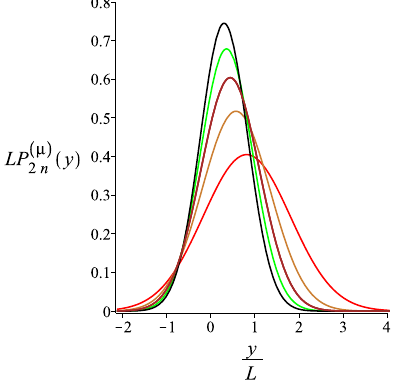
= 12.5. n = 2, and l p , φ µ = 0, φ B = π L 9 4